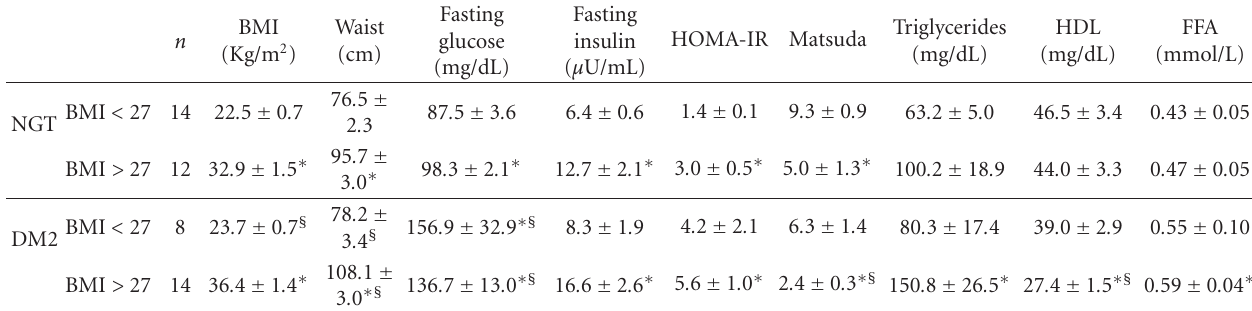
Triglycerides HDL FFA (mg/dL) (mg/dL) (mmol/L)